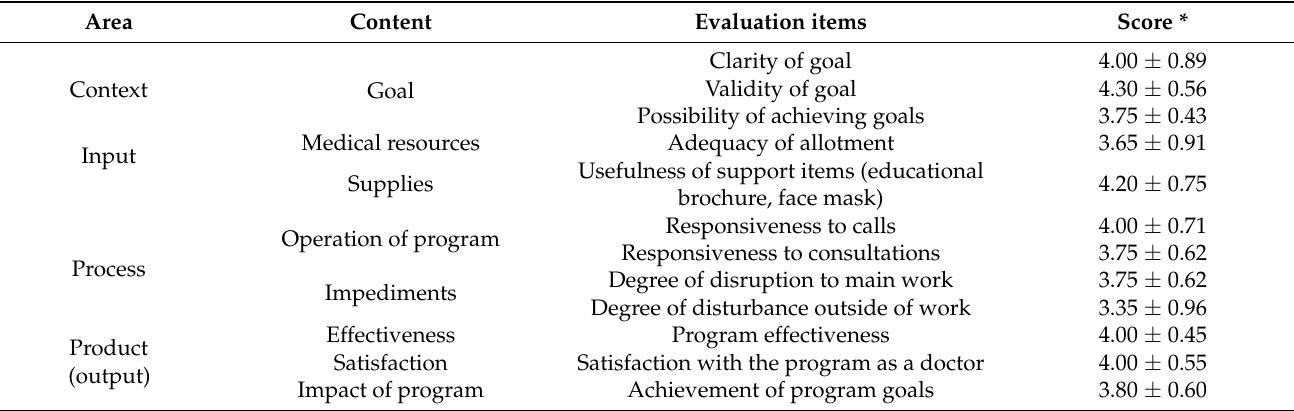
Table 4. Sub-area evaluation of the Follow-up Health Consultation Program by doctors.